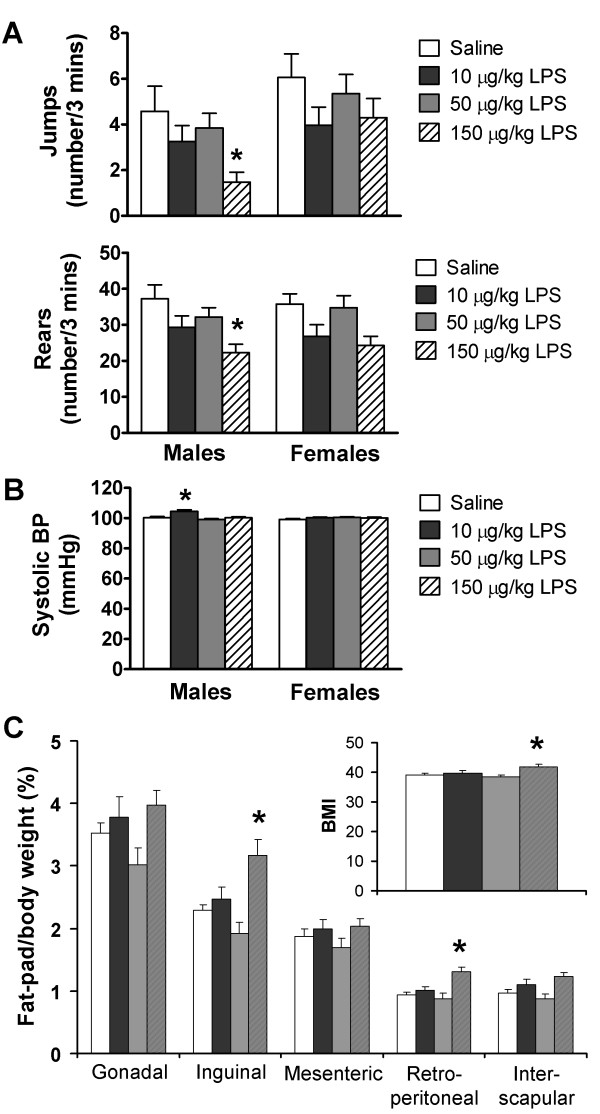
MPSI caused dose-dependent, gender-specific abnormalities in adult offspring behaviour and adiposity, but no abnormalities in systolic blood pressure (SBP). (A) Reduced jumping and rearing open-field activity in male, but not female, offspring from 150 μg/kg LPS dams. (B) Increased SBP in male offspring from 10 μg/kg LPS dams. (C) Increased fat pad to body weight ratio (%) and BMI in male offspring from 150 μg/kg LPS dams. All values represent means ± SEM. *P ≤ 0.05 vs. control independent of maternal origin and litter size (n = 6 mothers per treatment; n = 18 male and 18 female offspring per treatment).